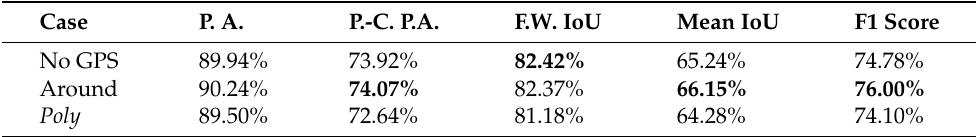
Table 4. Comparison of the accuracy obtained with the raw network prediction on the NP dataset and the one achieved when introducing OSM information from around and poly queries. P.A. stands for Pixel Accuracy, P.-C. for Per-Class, and F.W. for Frequency-Weighted. The best results are marked in bold.